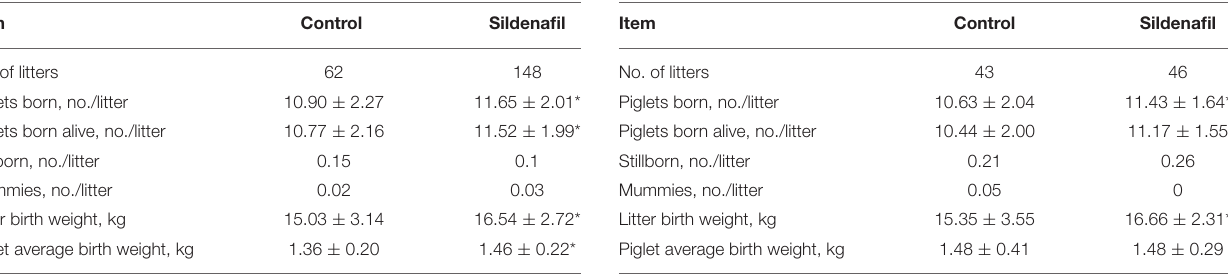
TABLE 1 | Effect of sildenafil intervention from day 0 to 110 of gestation on sow litter performance (means ± SD).